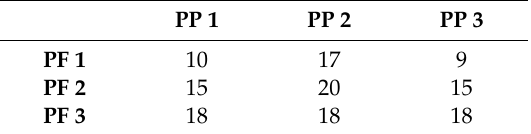
Table A2. Distance between Pretreatment Facilities and Power Plants in km.